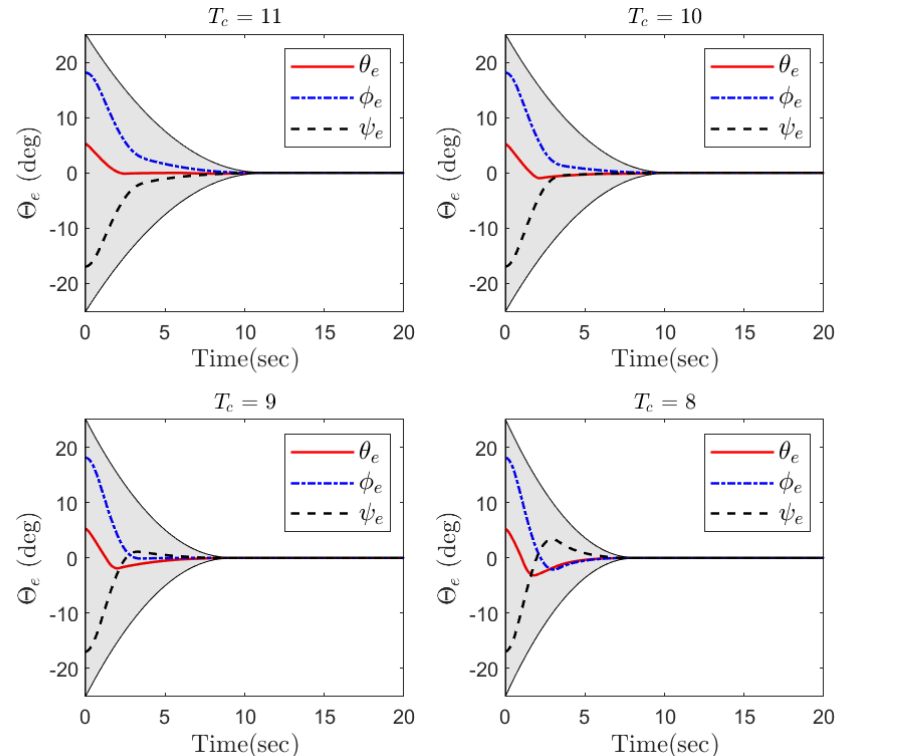
Figure 8. The attitude tracking error in Part 2.